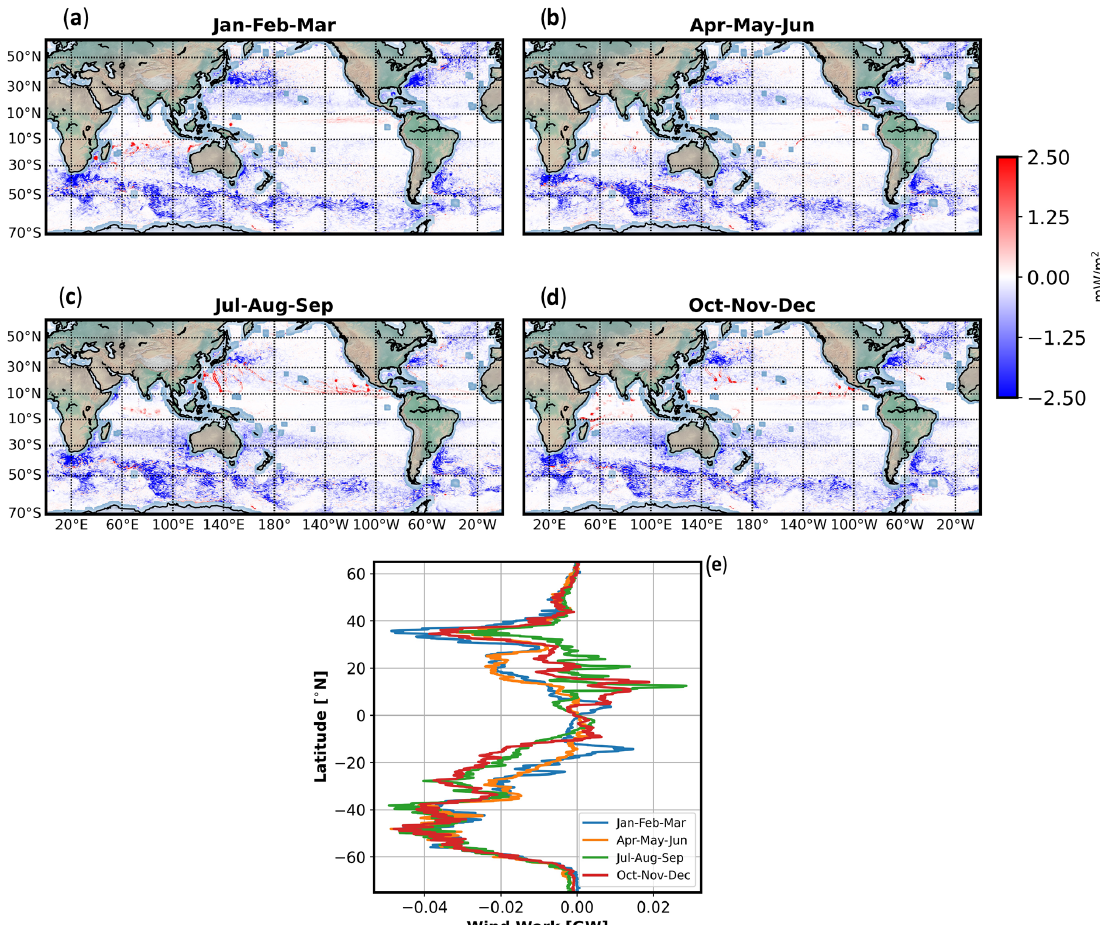
· u o (cid:48) . (e) Wind work lf < lf <